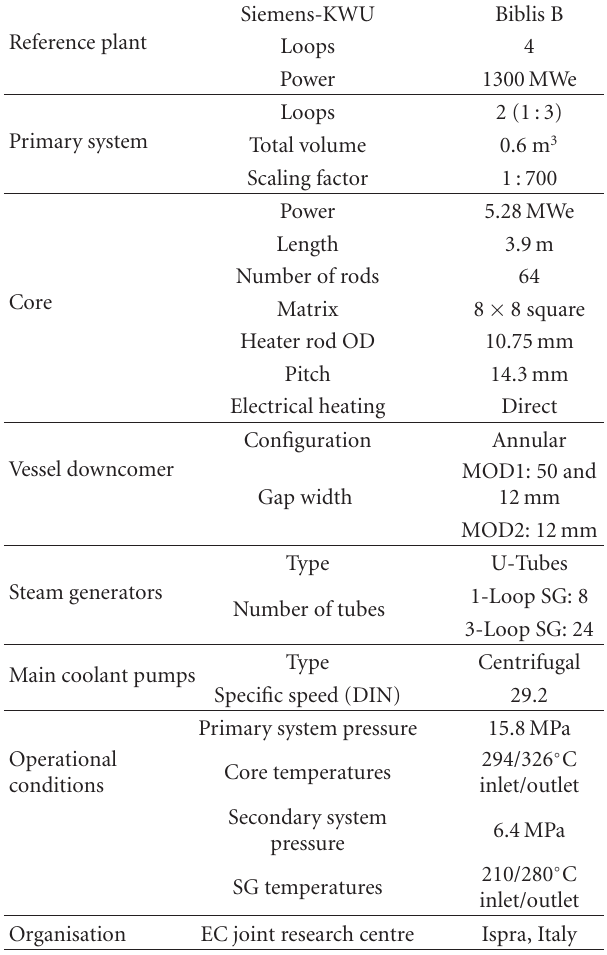
Table 1: LOBI test facility design and operational